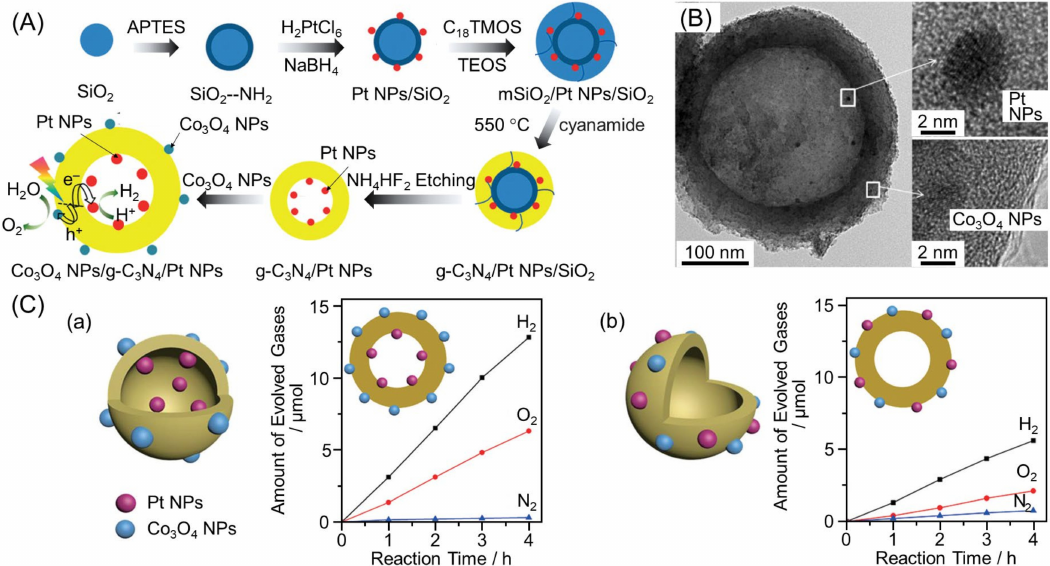
Figure 39. ( A ) Illustration of the preparation of Co 3 O 4 NPs/g-C 3 N 4 /Pt NPs composites. APTES, C18-TMOS, and TEOS represent 3-aminopropyl triethoxysilane, n -octadecyltrimethoxysilane, and tetraethoxysilane, respectively. ( B ) TEM and HR-TEM images of Co 3 O 4 NPs/g-C 3 N 4 /Pt NPs samples. ( C ) Time courses of photocatalytic evolution of H 2 and O 2 over ( a ) Co 3 O 4 NPs/g-C 3 N 4 /Pt NPs and ( b ) Co 3 O 4 NPs-Pt NPs/g-C 3 N 4 under UV-light irradiation ( λ > 300 nm). Reproduced with permission from reference [292]. Copyright 2016